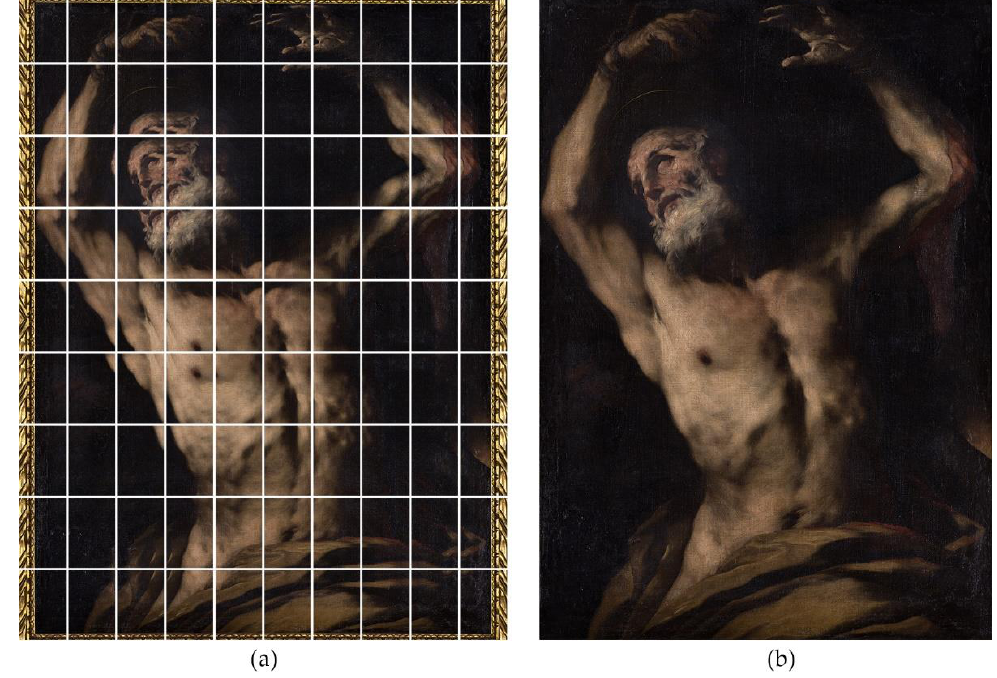
Figure 18. ( a ) Set of 90 pictures taken during the gigapixel capture. ( b ) Stitched gigapixel image. As in the previous cases, the RAW developing process was carried out with RAWTher- apee to apply the proper white balance and the specific colour profile to all the pictures at once. The stitching was carried out with PTGUI, which provided a gigapixel image (Figure 18b) with a total resolution of 30,884 × 44,228 px (1.36 gigapixels). In this case, the pixel density was 826 ppi, something lower than in the previous case due to the larger distance between the camera and the canvas. Figure 19 shows a cropped fragment of the gigapixel image focused on the saint’s